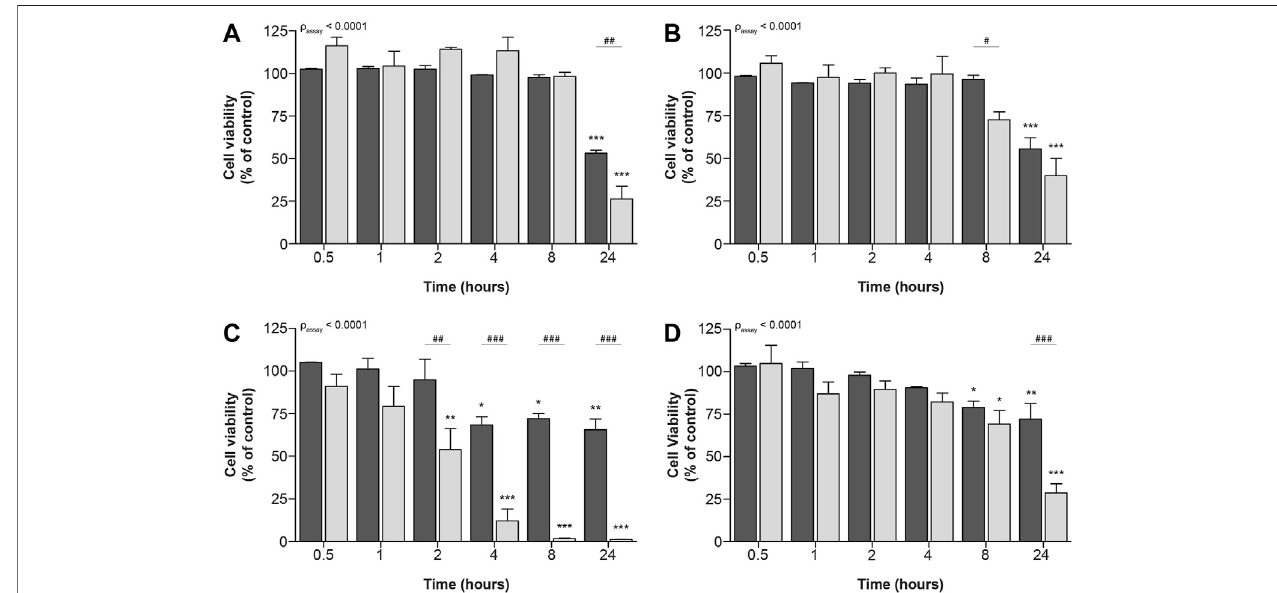
FIGURE 3 | Time-dependent effects upon exposure of ciPTEC-OAT1 to IC 90 -concentrations of nephrotoxic drugs on cellular metabolic activity and fl uorescence-based cell death. Mature ciPTEC-OAT1 were exposed to IC 90 -concentrations of nephrotoxic drugs for 0.5, 1, 2, 4, 8 or 24 h, after which fl uorescence-based cell death ( ■ ) or cellular metabolic activity ( ■ ) assays were performed. (A) cisplatin, (B) tenofovir, (C) sanguinarine, (D) chloroacetaldehyde. For IC 90 -valuessee table 1 .Allresultswerenormalized tounexposed controls. Statisticalanalyses:one-wayANOVA corrected for multiplecomparisonby Dunnett ’ s post hoc analysis to compare differences between vehicle control and exposed conditions * p < 0.05, ** p < 0.01, *** p < 0.001; and two-way ANOVA corrected for multiple comparison by Bonferroni ’ s post hoc analysis to compare differences between assays # p < 0.05, ## p < 0.01, ### p < 0.001. p -value corresponding to overall signi fi cance between assays is indicated for each compound. Mean ± SEM; n = 3 independent experiments.